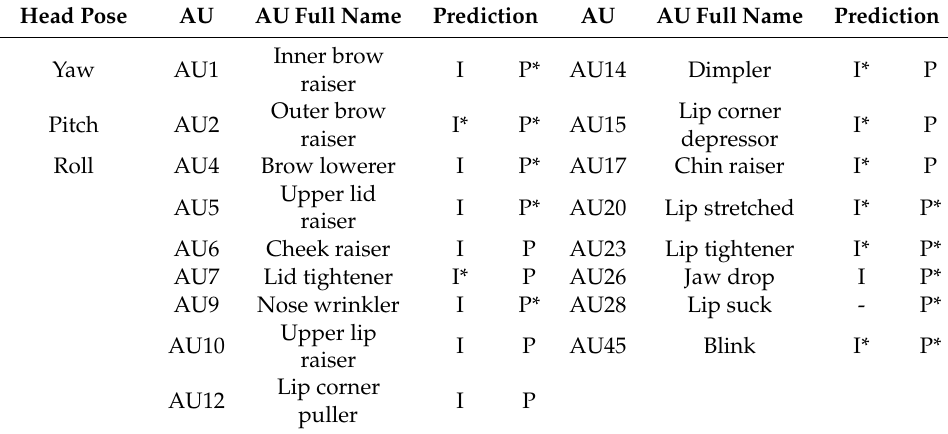
Table 1. List of extracted facial features in OpenFace (I—intensity,